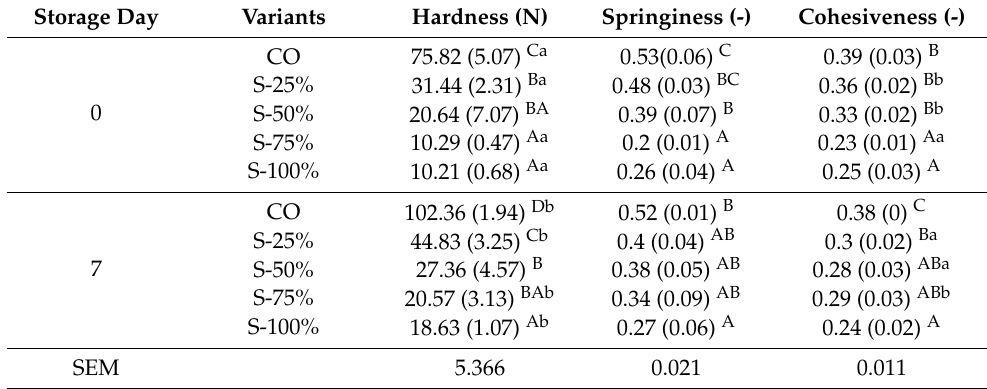
Table 2. Influence of freeze-dried hydrogel emulsions with the encapsulation açai oil as a fat substitute on the texture parameters (TPA) of grilled burgers at 0 and 7 storage day. Storage Day